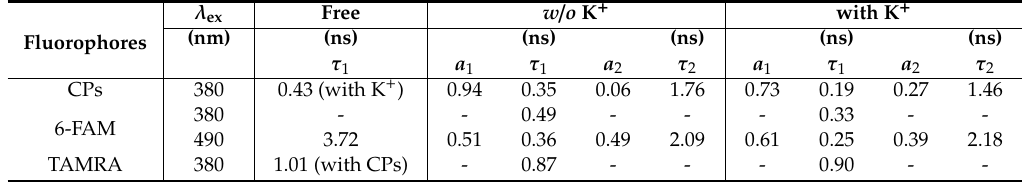
Table 1. The fitted parameters for the fluorescence decay of CPs, 6-FAM, and TAMRA.